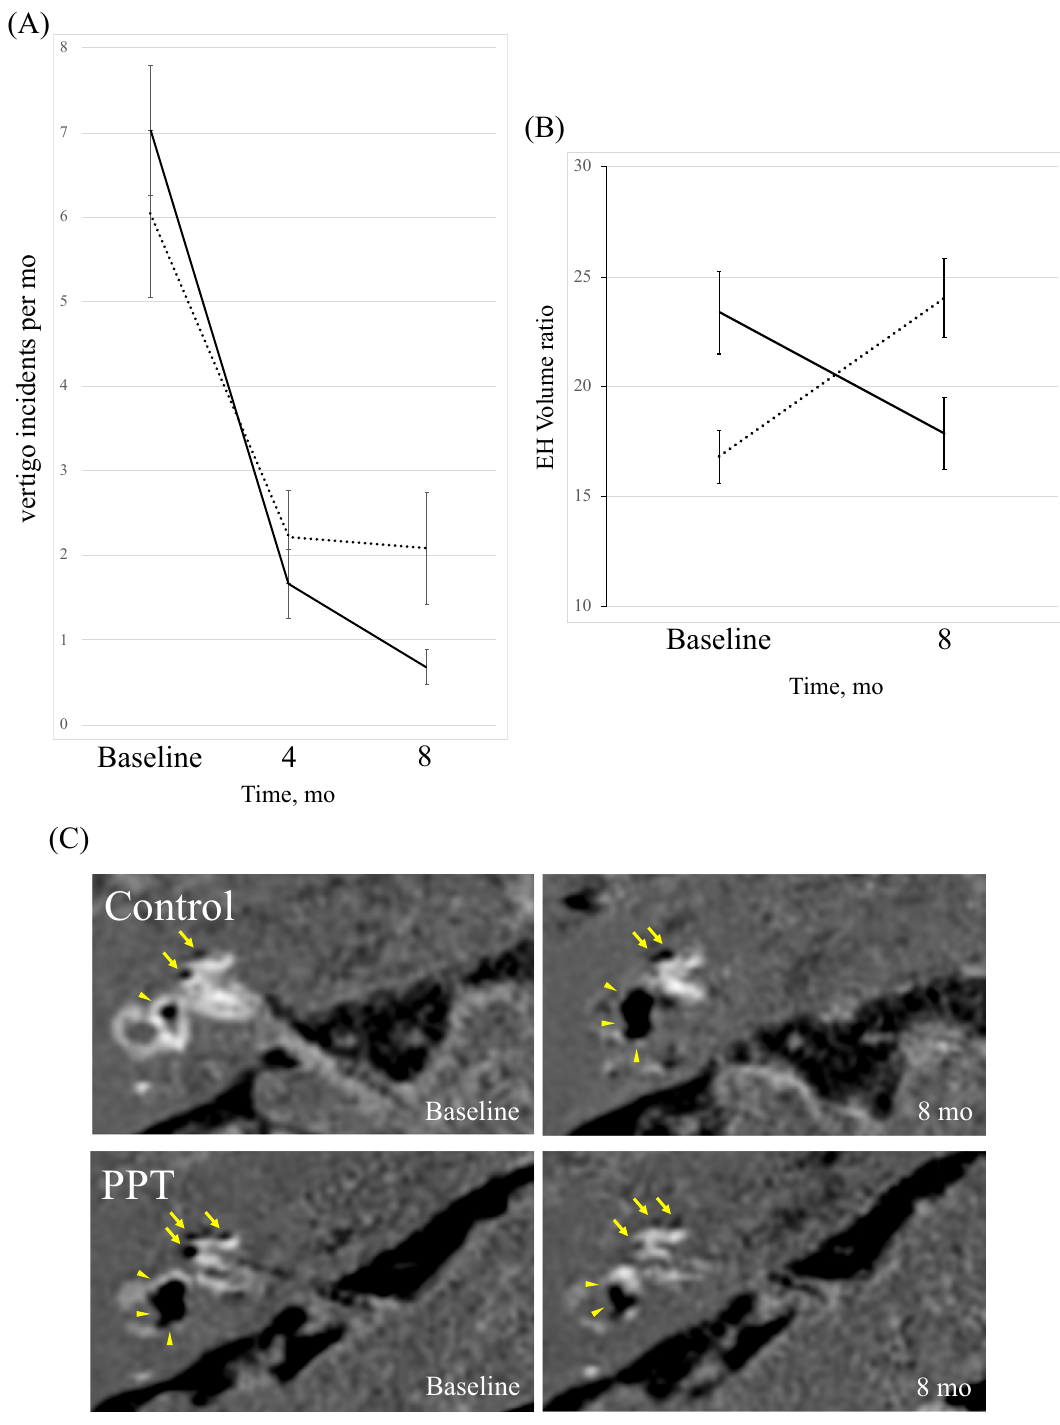
Figure 2. Changes in frequency of vertiginous episodes and Endolymphatic hydrops volume between two controlled groups. EH indicates endolymphatic hydrops, PPT indicates positive pressure therapy and MRI, magnetic resonance imaging. ( A ) Changes in incidents of vertigo between Control and PPT groups. ( B ) Change in volume ratio of total EH between Control and PPT groups. Error bars represent SE of the mean. Dotted line and solid line show Control group and PPT group, respectively. ( C ) Representative MRI. The black areas within the labyrinth represent EH. Yellow arrows and arrowheads indicate cochlear EH and vestibular EH, respectively. Upper half of image indicates mild EH in right cochlea and vestibule at baseline (upper half, left) and significant EH in right cochlea and vestibule 8 months later (upper half, right) in Control group. Lower half of image indicates significant EH in right cochlea and vestibular at baseline (lower half, left) and mild EH in right cochlea and vestibule 8 months later (lower half, right) in PPT